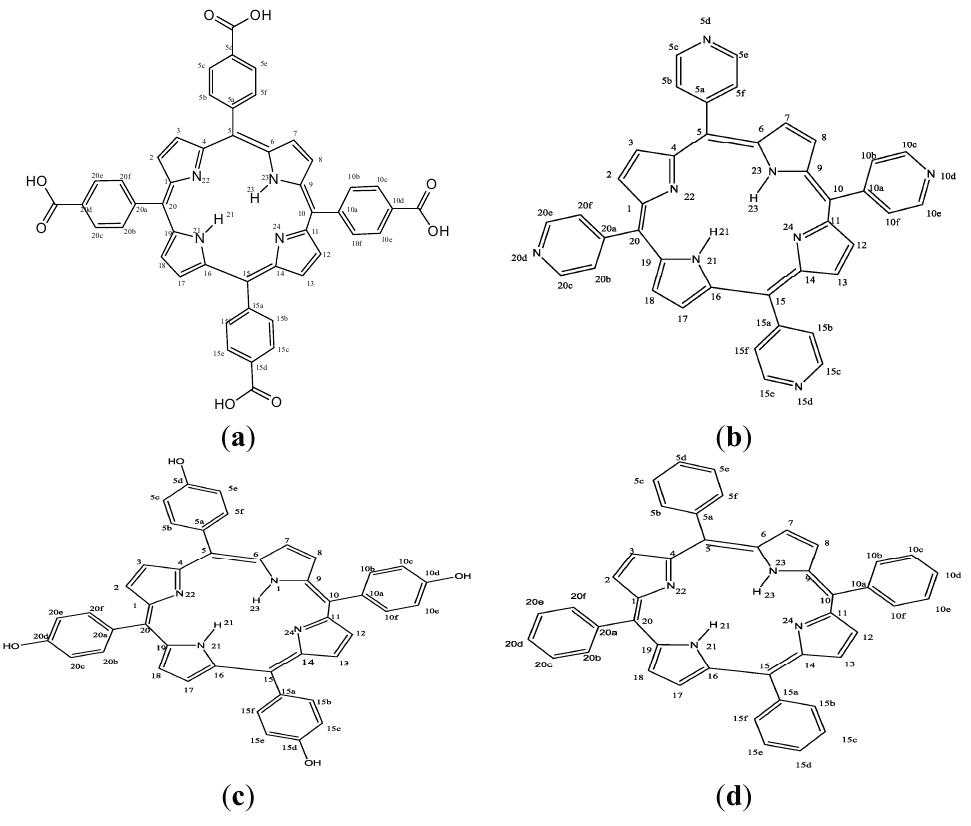
Figure 1. Molecular structures of the studied porphyrins. ( a ) 4,4,4,4-(porphyrin-5,10,15,20- tetrayl)-tetrakis(benzoic acid (HPTB); ( b ) 5,10,15,20-tetra(4-pyridyl)-21 H ,23 H -porphyrin (T4PP); ( c ) 5,10,15,20-tetrakis(4-hydroxyphenyl)-21 H ,23 H -porphyrin (THP); ( d ) 5,10,15,20- tetraphenyl-21 H ,23 H -porphyrin